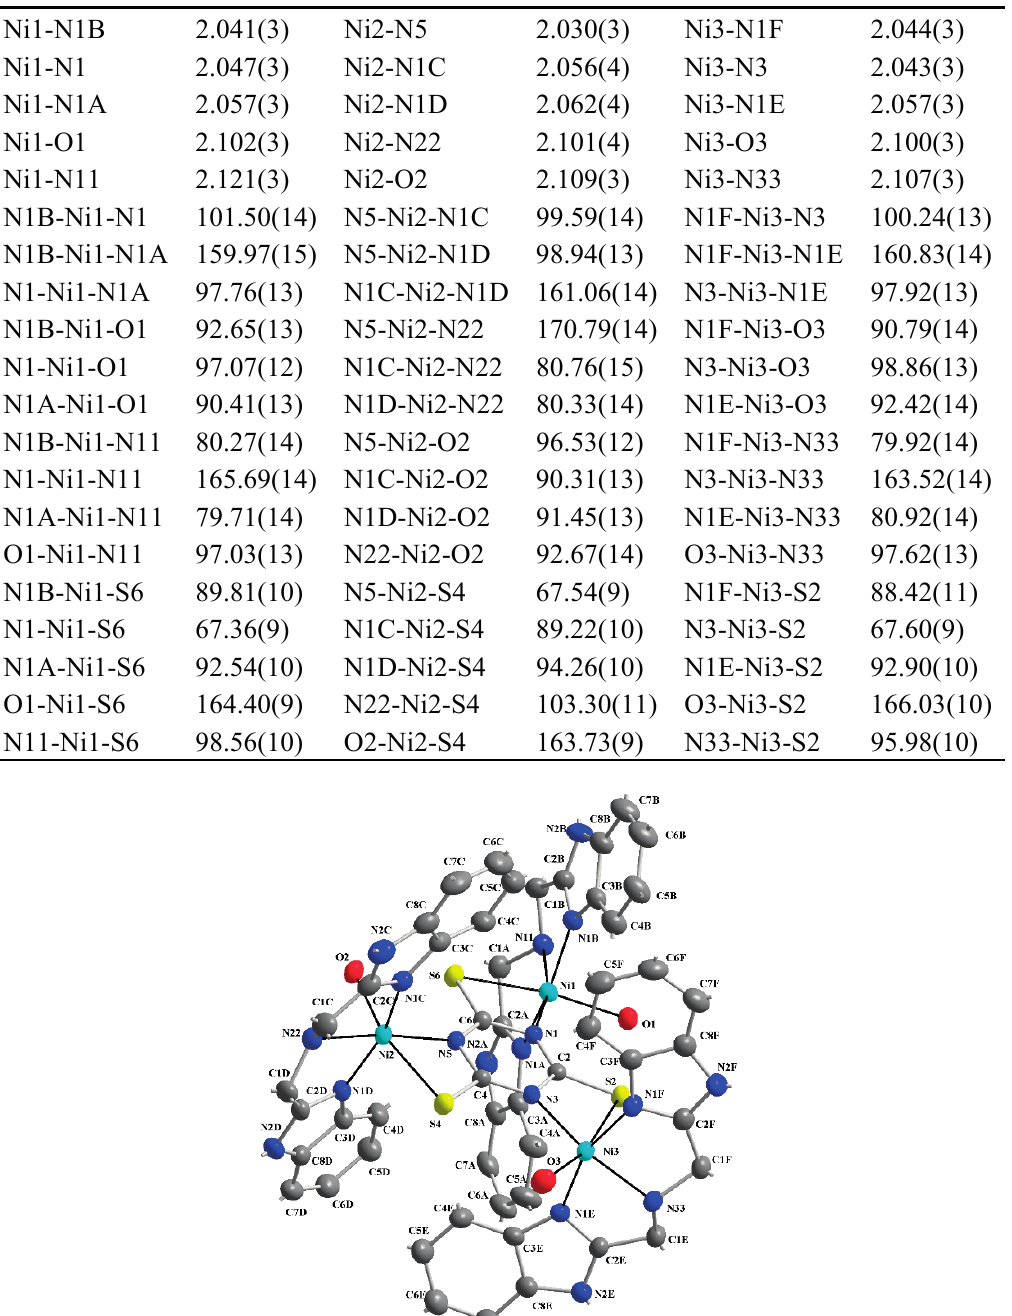
Table 1. Selected bond lengths (Å) and angles (°) for 1 .